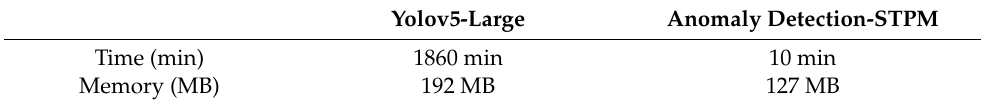
Table 4. Comparing time and memory for Yolov5-Large and Anomaly Detection-STPM.